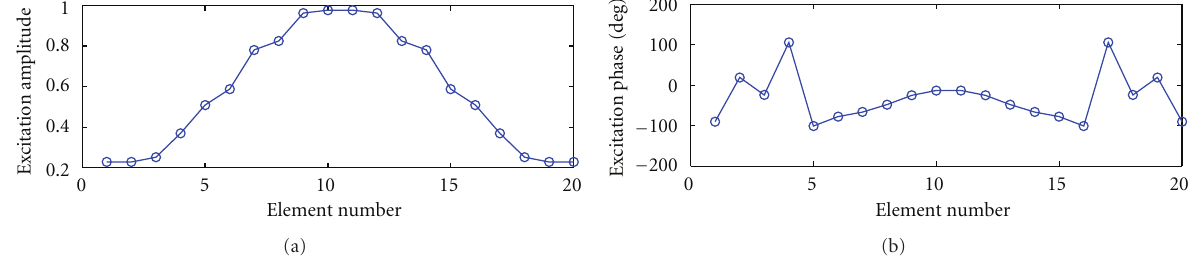
Figure 5: Amplitude and phase excitation (experiment I) with coupling e ff ect.